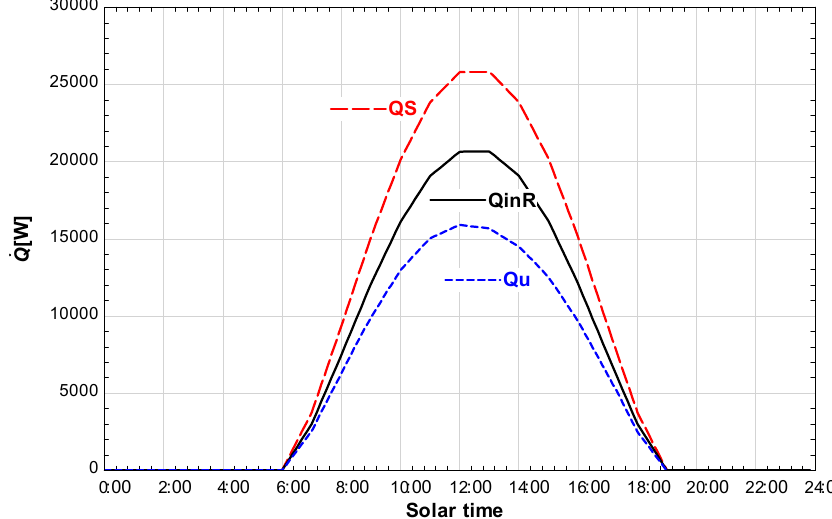
.  , input heat rate to the tubular receiver Rin Q , Q S , input heat rate to the tubular receiver .  Q u for the studied for the studied case.